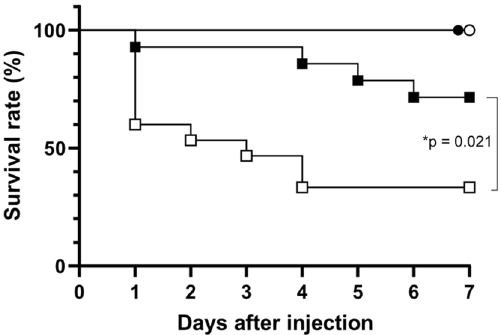
Figure 1. Temperature sensitivity of common goldfish for Pseudomonas infection . After the acclimation period, the common goldfish were divided into four groups as descried in the Materials and Methods section (two infection paradigms and two temperature paradigms). The goldfish were either infected ( P. aeruginosa ; ◦ ◦ 3 × 10 7 CFU) or uninfected (saline) at either 25 C or 33 C. Survival curve for each group is shown in the figure over 7 days after the infection. Results from two experiments were combined and shown in the figure. Symbols: (saline, 25 ℃ , n = 8), ○ (saline, 33 ℃ , n = 9), ■ ( P. aeruginosa infection, 25 ℃ , n = 14) and □ ( P. aeruginosa infection, 33 ℃ , n = 15). There was a statistically significand difference between the survival curves of ● ◦ P. aeruginosa infection (25ºC) and P. aeruginosa infection (33 C) groups (P = 0.021 by Log-rank test).